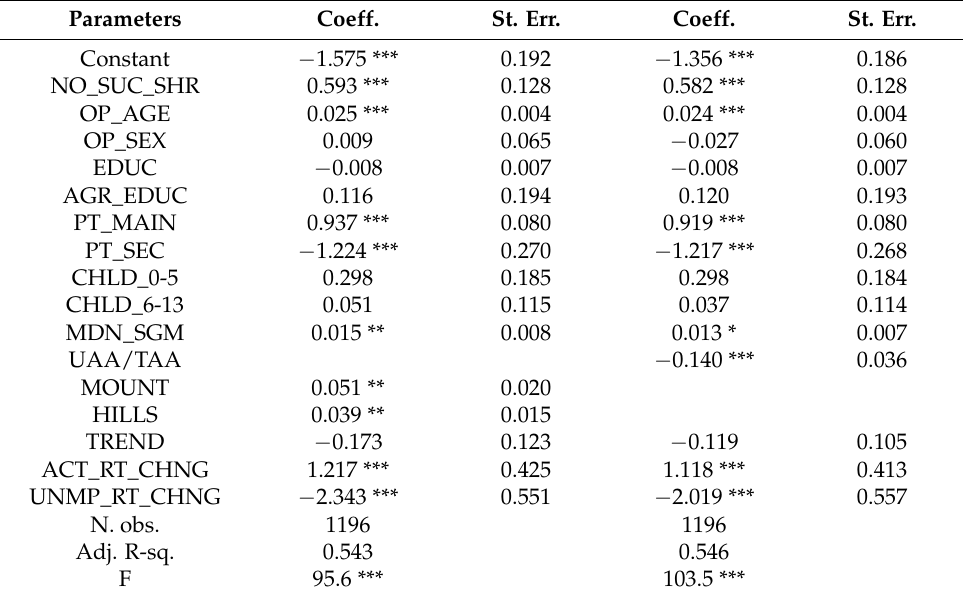
Table A2. Parameter estimates of the number of farms decrease rate model using the all farms database. Parameters Coeff. St. Err.